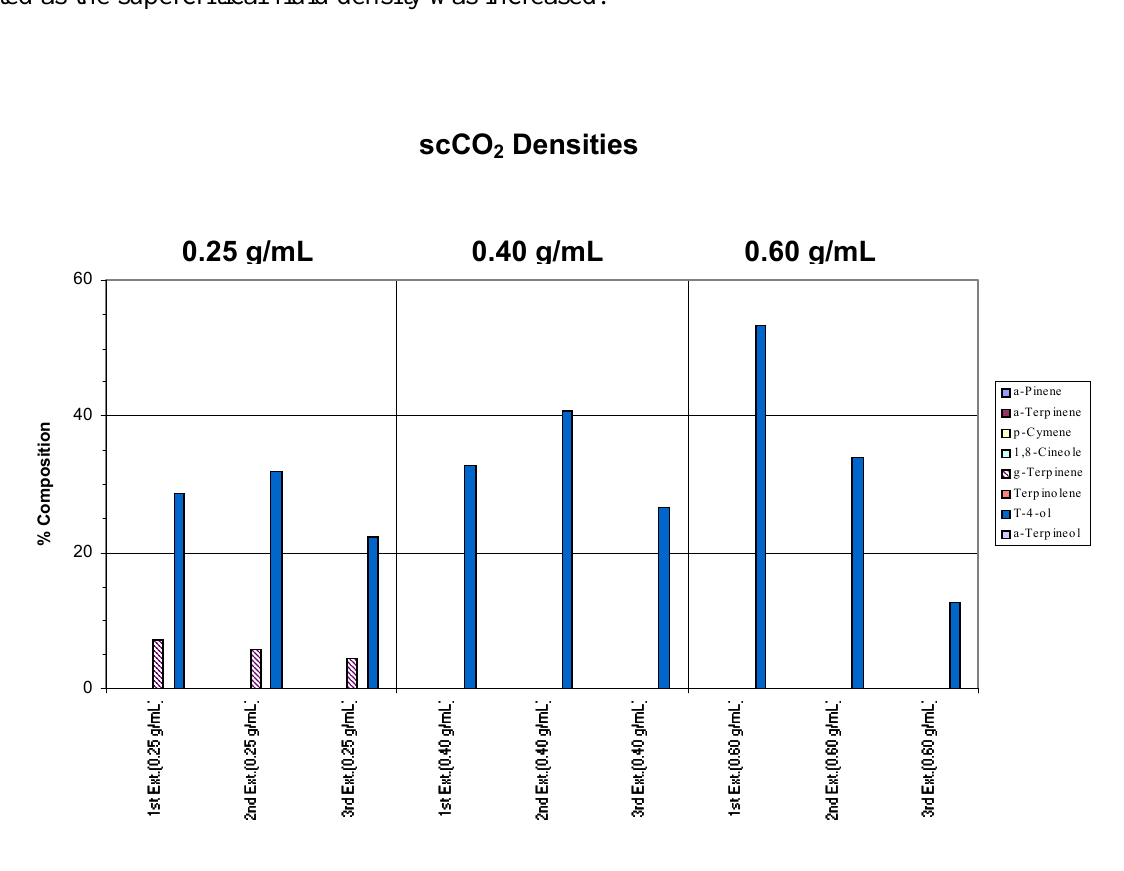
Figure 2a. Extraction of whole fresh leaves at densities of 0.25, 0.40 and 0.60 g/mL and a chamber temperature of 40 o